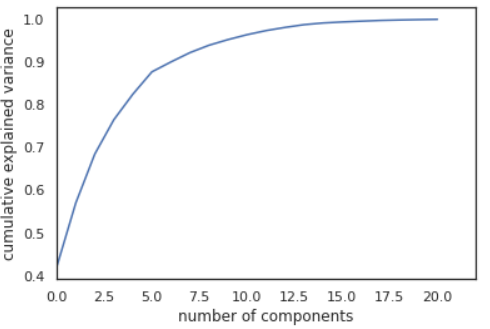
Figure 4. Number of features and their cumulative variance in the WBCD